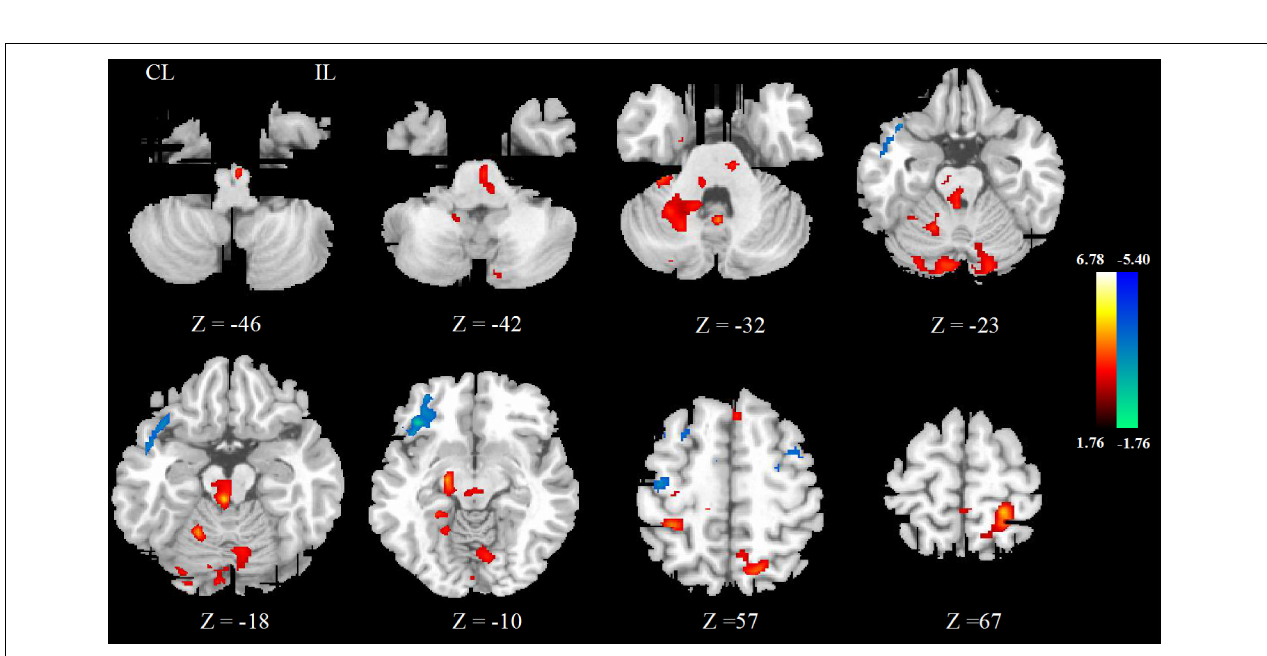
FIGURE 2 | The change of CBF between pre- and post-rTMS treatment. The blue color represents the decreased areas of CBF value, and the red color represents the increased areas of CBF value. CL, contralesional; IL, ipsilesional.